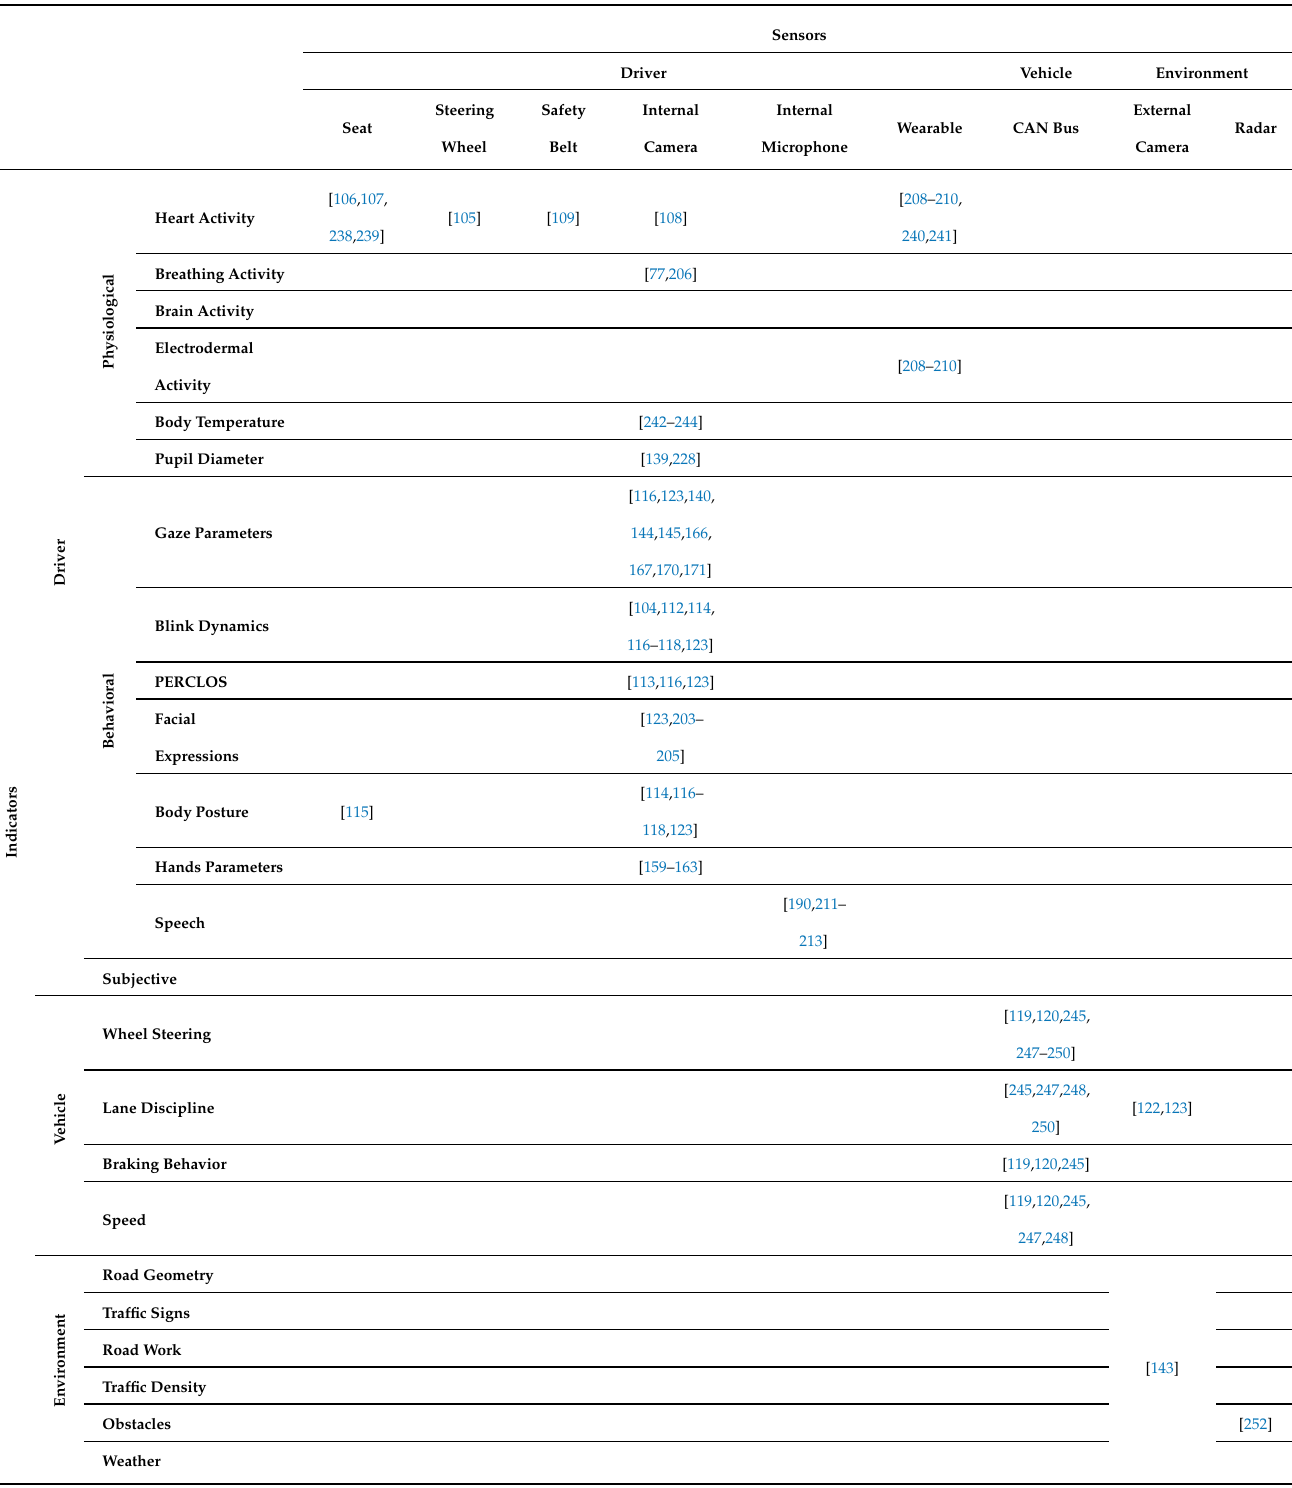
Table 5. Detailed “sensors vs. indicators” table, introduced in simplified form in Figure 3. Each cell in the heart of the table gives some references (if any) discussing how the corresponding sensor is useful for characterizing the corresponding indicator. The indicators are identical to the ones in Table 4, thereby allowing one to link both